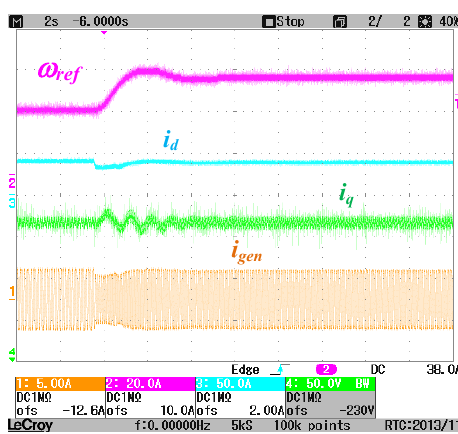
Fig. 17. Response for step change of speed without APFF. From top: estimated speed ( ω gen ), current in d-axis ( i d ), current in q-axis ( i q ), generator current ( i gen ).